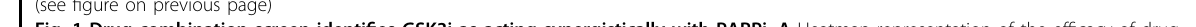
Fig. 1 Drug combination screen identi fi es GSK3i as acting synergistically with PARPi. A Heatmap representation of the ef fi cacy of drug combinations. Screening of drug combinations was performed in BRCA1-de fi cient HCC1937 and BRCA2-de fi cient HCT-15 cells. Prior to screening, olaparib (OP) and niraparib (NP) were arrayed in 96-well plates and serially diluted 2-fold, and Sulforhodamine B (SRB) assay was used to analyze cytotoxicity to obtain a concentration that was 20% of the inhibition rate (IR). Data pertaining to single-agent activities of the drug library (99 agents targeting 50 classes of proteins) suggested that the active concentrations ranged from ~10 nM to ~10 μ M. For the combination experiments, cells were treated with the compounds at three concentrations covering a 100-fold concentration range (10-fold dilution), with or without a fi xed dose of OP or NP (~20% IR). In HCC1937 cells, 3.5 μ M OP or 3.5 μ M NP; in HCT-15 cells, 20 μ M OP or 2.5 μ M NP. A drug response score, indicating the effect of PARPi combined with the indicated agent, was calculated as Δ IR. For each screened drug dose, a Δ IR was calculated: Δ IR = inhibition rate of (combination IR3 – indicated agent IR1 – PARPi IR2), the closed and open left angle triangle represent two different inhibitors from the same drug target, and their concentration decreases from left to right. B and C Effect of single agent and combination treatment on HCC1937 and HCT-15 cells viability for combinations of PARP inhibitor (olaparib, OP), plus CDK1 inhibitor (CDK1i) RO-3306 ( B ) or ATR inhibitor (ATRi) VE-821 ( C ). Cell viability was measured by Sulforhodamine B (SRB) assay. Combination index (CI) was calculated using CompuSyn software with the Chou – Talalay equation, and average CI values are presented (CI < 1, synergism; CI = 1, additive effect; CI > 1 antagonism). Data are from three independent experiments and expressed as mean ± standard deviation